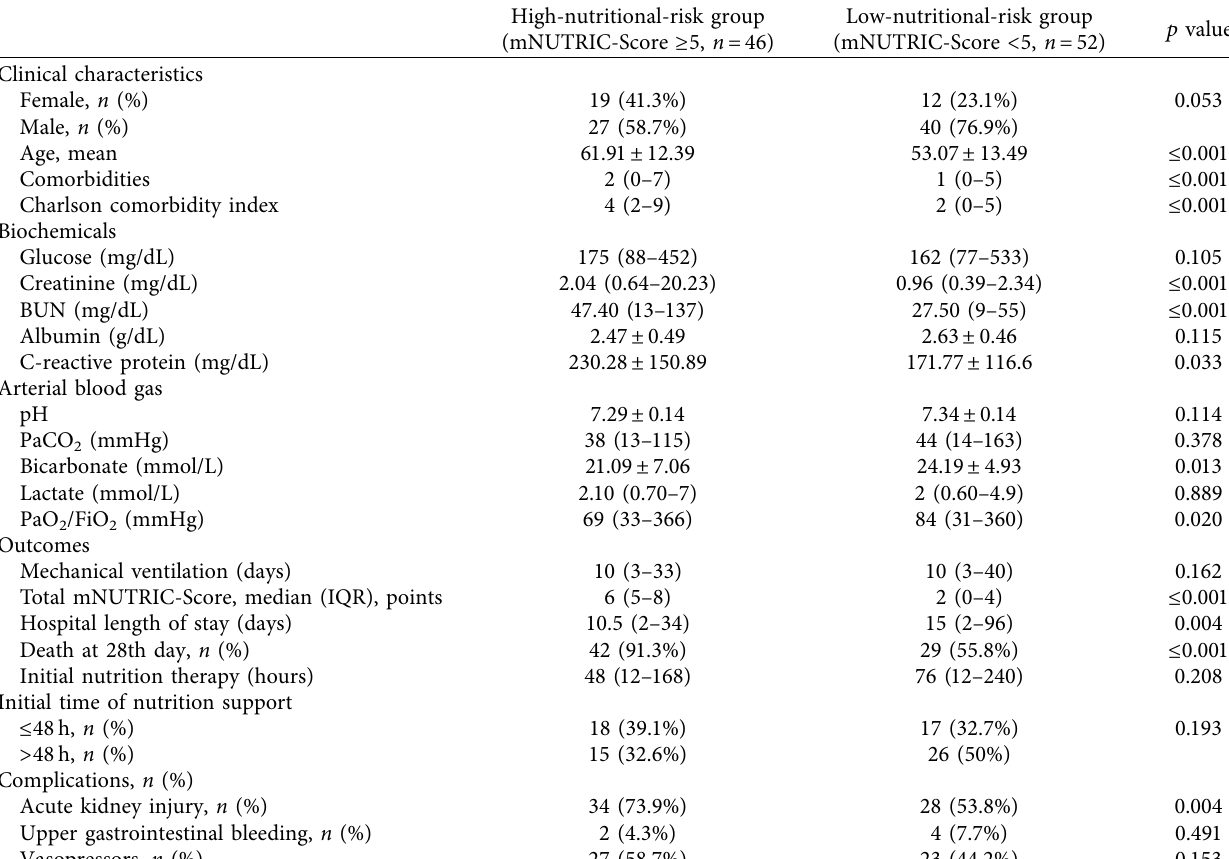
Table 2: Characteristics and laboratory indices among patients with high and low nutritional